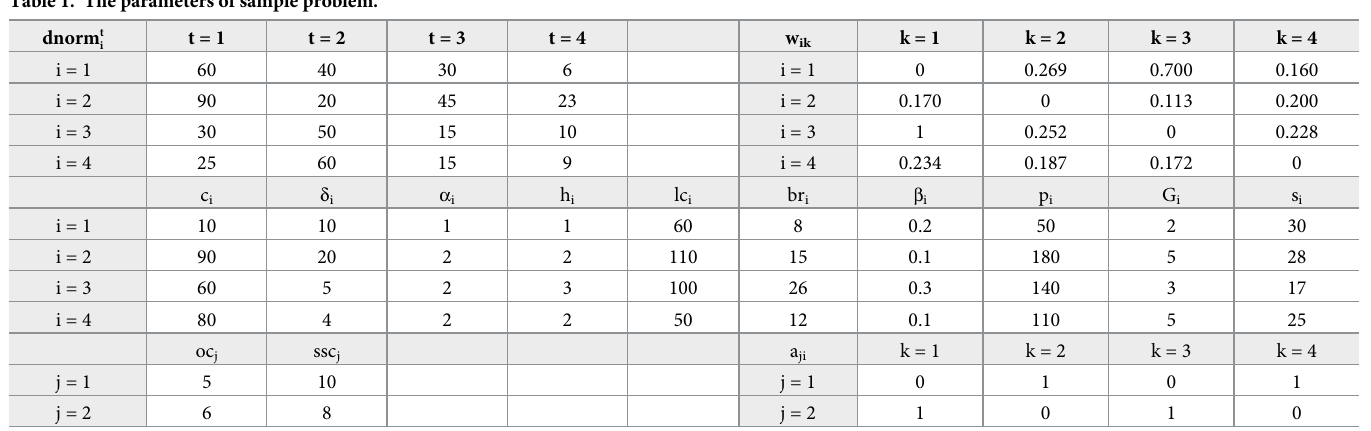
Table 1. The parameters of sample problem.